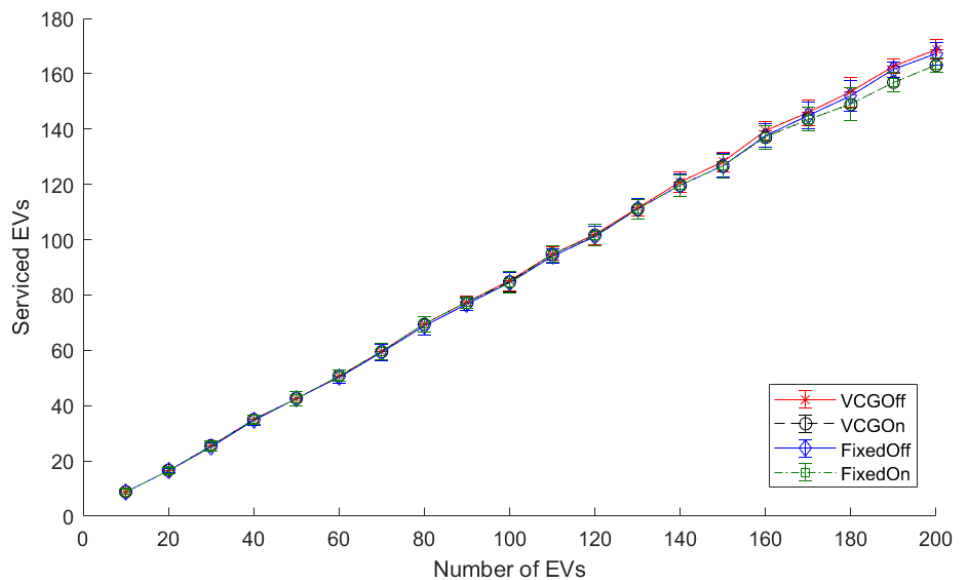
Figure 4. Average number of serviced